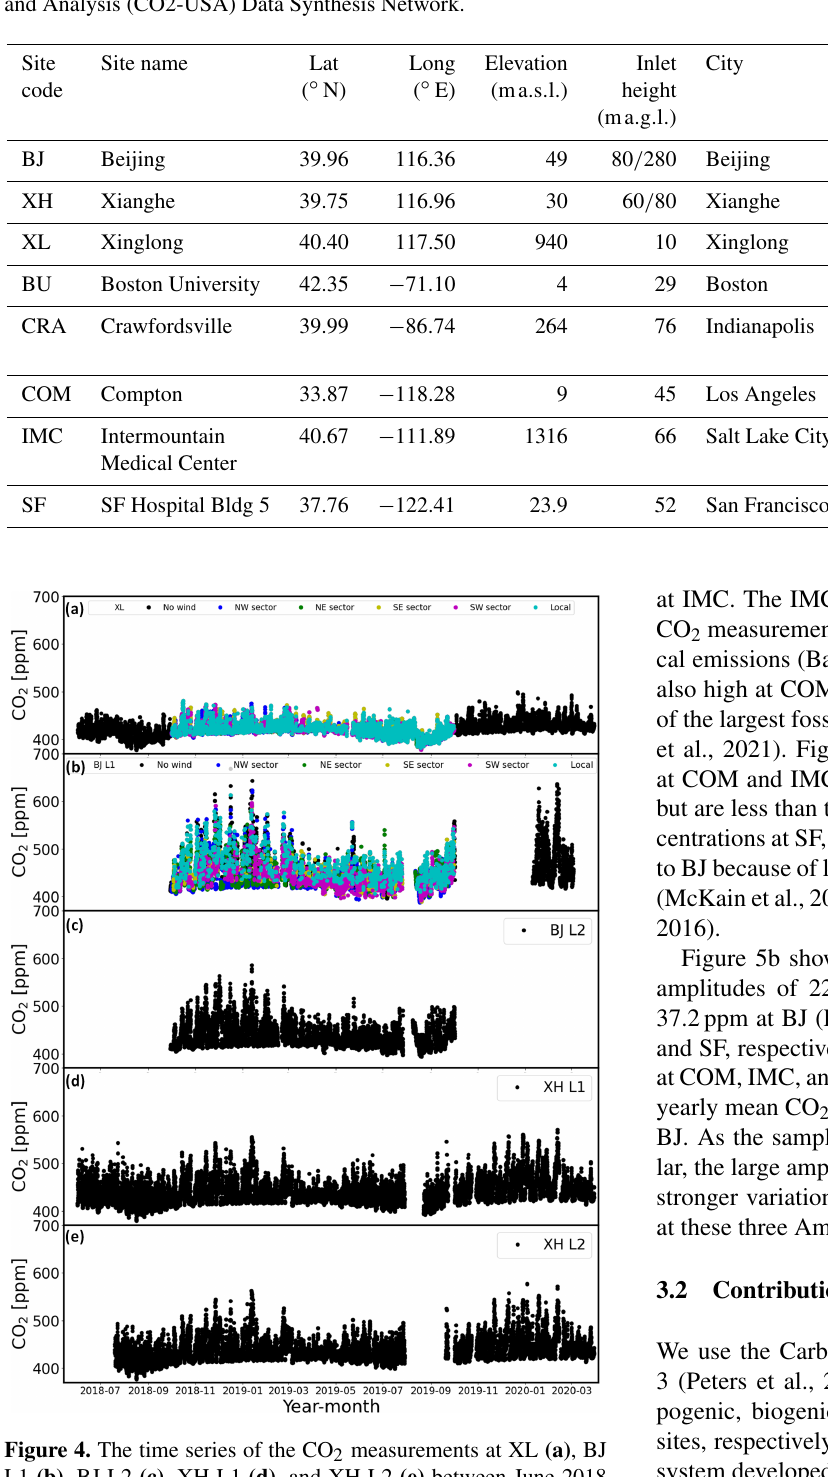
Table 1. Site characteristics of BJ, XH, and XL in North China and BU, CRA, COM, IMC, and SF in the USA from the CO 2 Urban Synthesis and Analysis (CO2-USA) Data Synthesis Network.